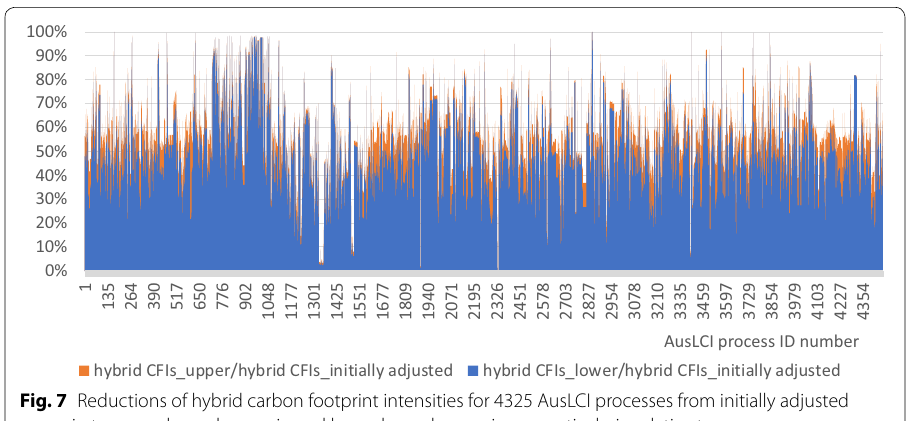
Fig. 7 Reductions of hybrid carbon footprint intensities for 4325 AusLCI processes from initially adjusted scenario to upper-bound scenario and lower-bound scenario, respectively, in relative